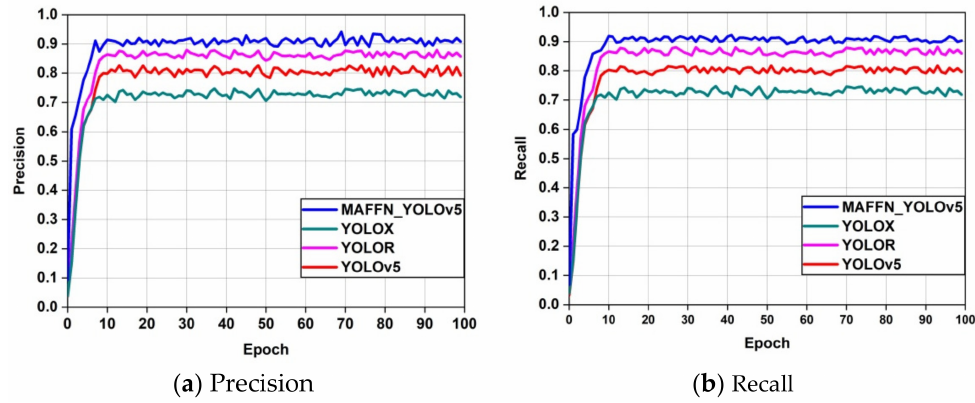
Figure 21. Comparison of the Precision and Recall plots on the coral-reef